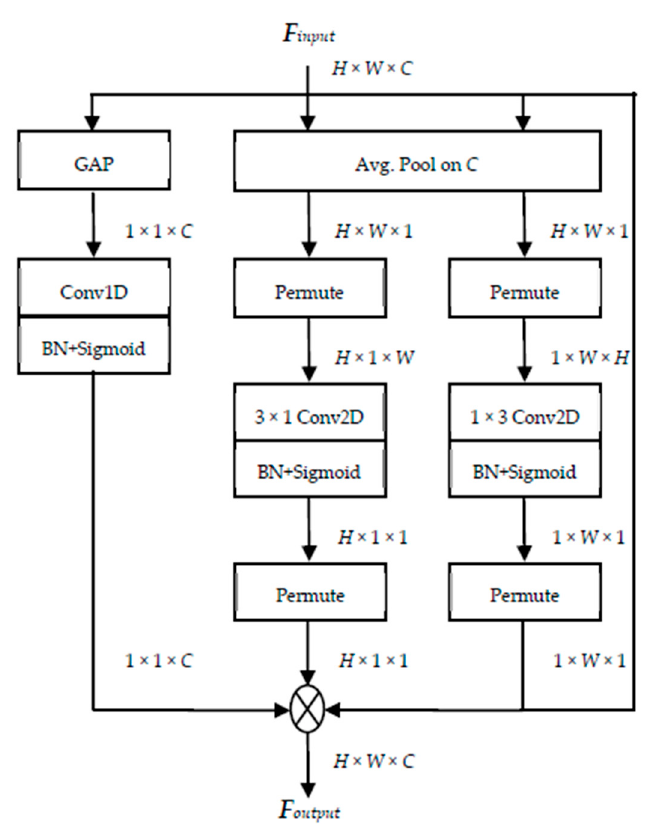
Figure 2. Graphical outlines of the proposed LCAM.